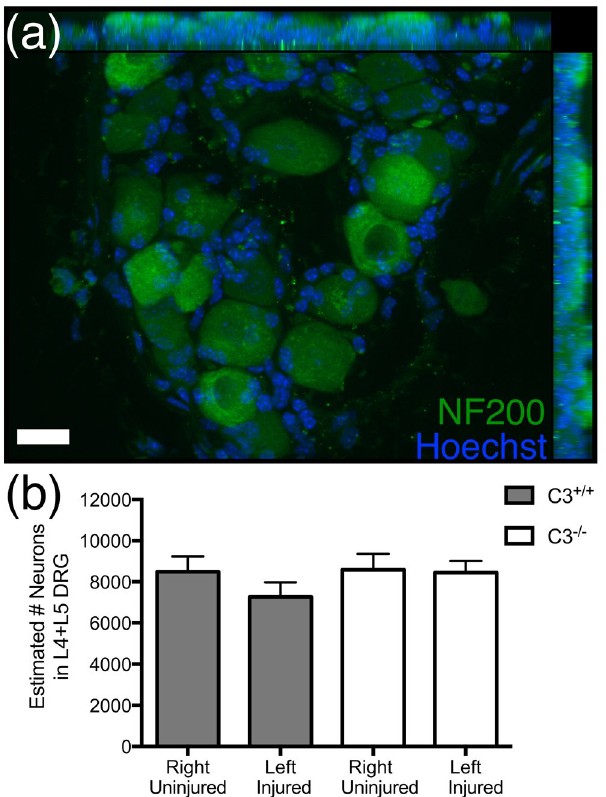
Figure 2. Complement C3 knockout mice did not exhibit DRG neuron loss following sciatic nerve transection. ( a ) Representative section of a right (uninjured) L4 DRG from a C3 + / + mouse for quantification, showing immunofluorescent labeling for NF200 + DRG neurons (green) with Hoechst counterstain (blue). ( b ) Quantification of L4 + L5 DRG neuron number for uninjured (right) DRGs and injured (left) DRGs in C3 + / + and C3 − / − mice by stereology demonstrated a lack of injury-induced neuron loss in C3 − / − mice (p > 0.05 one- way ANOVA). N = 5 C3 − / − , N = 3 C3 + / + . Mean ± SEM. Scale bar = 10 μ